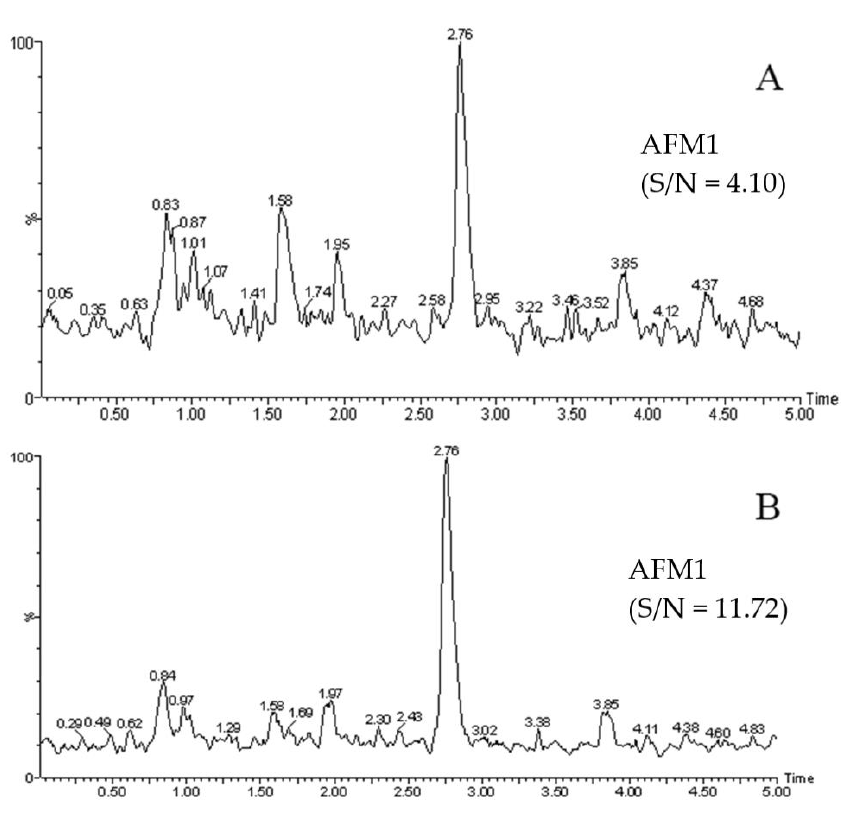
Figure 4. Extracted ion chromatograms of AFM1-spiked milk by the immunoaffinity method clean-up (( A ): 0.005 μg/kg , ( B ): 0.015 μg/kg ).